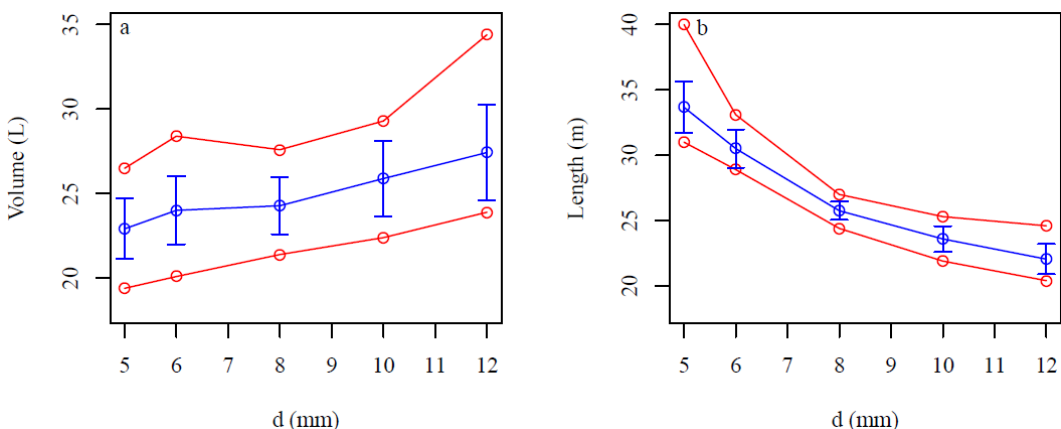
Figure 11. Sensitivity of QSMs for the d (the minimum distance between the centers of the balls and the maximum distance between any point and its nearest center) and l (relative cylinder length) parameters for the root portion. ( a , c ) Total root portion volume and ( b , d ) linear root length for different ( a , b ) d values and ( c , d ) l values. Blue lines are the averages, vertical blue bars are the standard deviations, and red lines are the minimum and maximum values for 15 model fits of stump